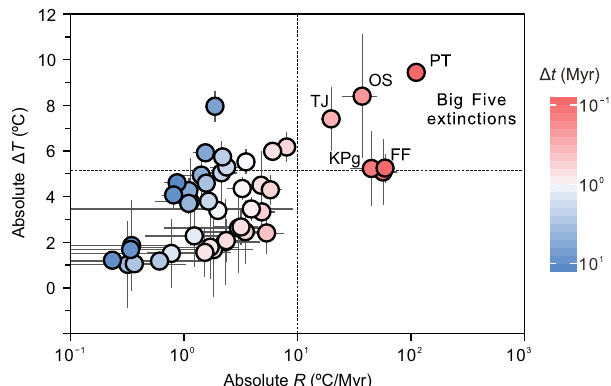
Fig. 3 Cross plot of magnitude versus rate of temperature change. Higher magnitude climate change tended to occur at faster rates. The Big Five extinction events fall in the area of Δ T > 5.2 °C, R > 10 °C/Myr, and timespan ( Δ t ) < 0.4 Myr, thus de fi ning the broad climate thresholds that lead to mass extinction of marine animals. As made clear in the main text, the plotted magnitudes and rates pertain to those that occur within each of the 45 de fi ned time intervals. Horizontal and vertical bars show mean ± 1 x standard deviation (see Methods). The colour of dots represents the timespan of each climate event. Source data are provided as a Source Data fi